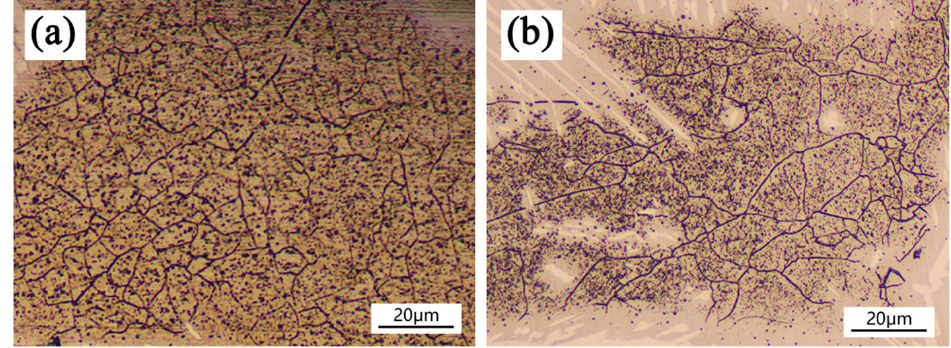
Figure 7. X-ray as-cladded and as-remelted coatings. ( a ): fine grain δ , ( b ): coarse grain δ .